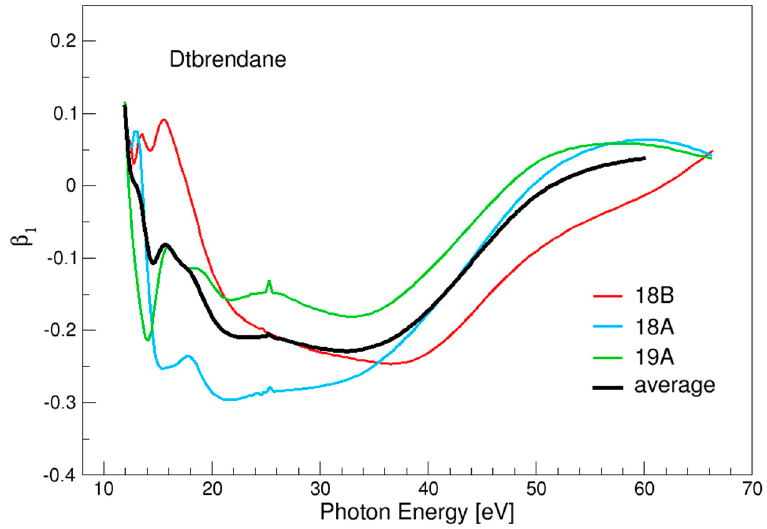
Figure 8. β 1 parameter for the three outermost ionizations, 18B, 18A and 19A, and the average value, in ditwistbrendane.